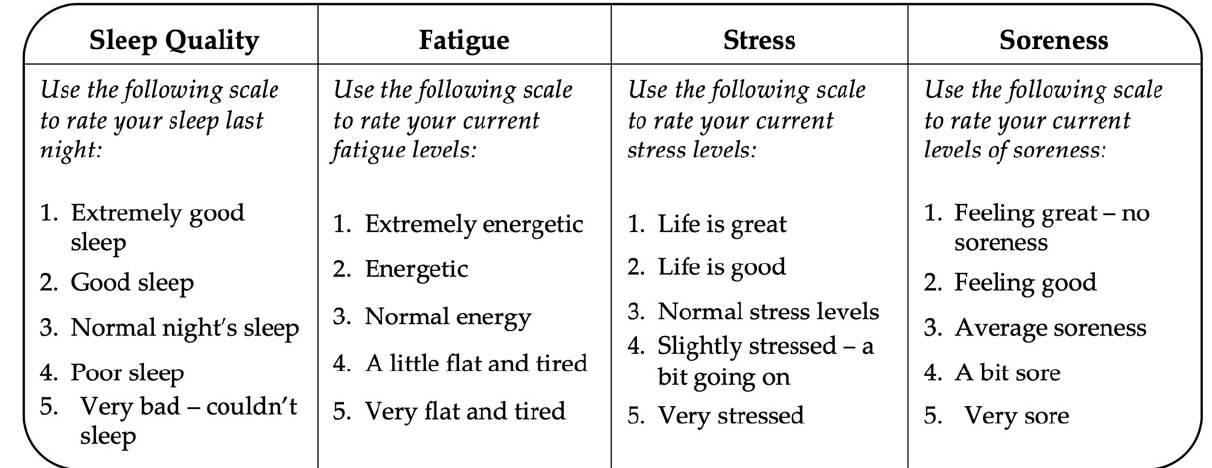
Figure 1. Wellness questionnaire, adapted from McLean and colleagues [23] .